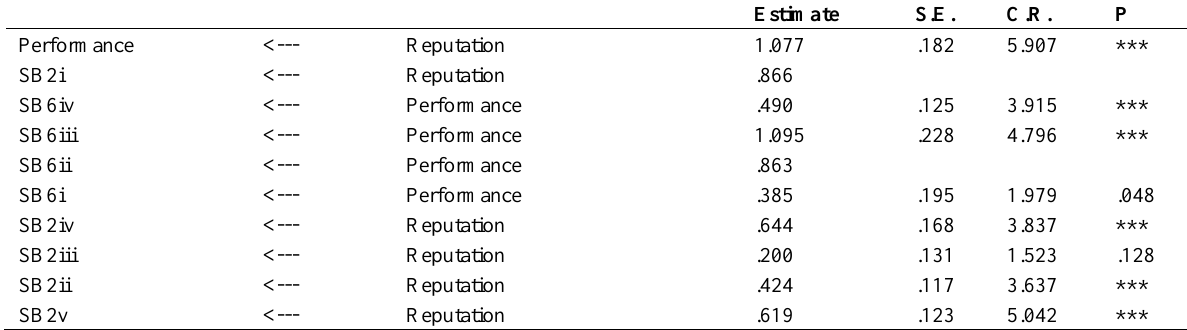
Table 4: Regression Weights for corporate reputation and